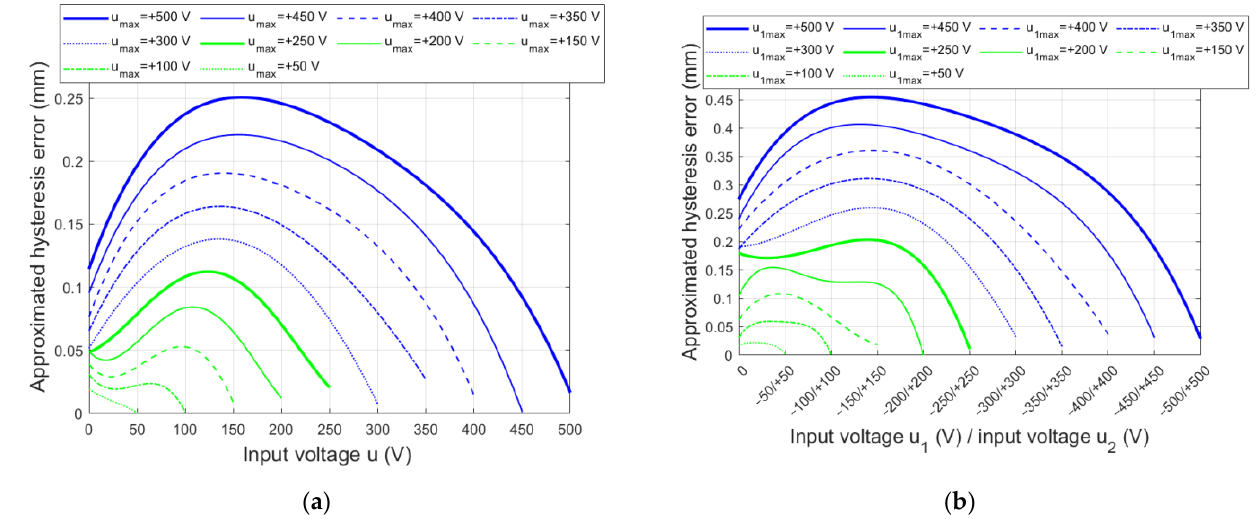
Figure 16. Approximated hysteresis errors ( a ) in the unimorph movement, and ( b ) in the bimorph movement, for u 2min = –u 1max .